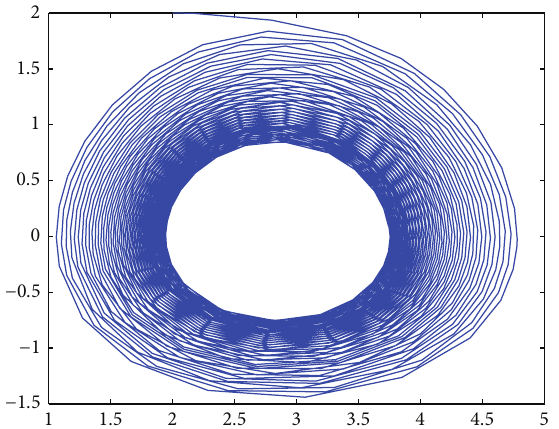
Figure 4: 𝜏 1 = 0 , 𝜏 2 = 0.7237 , (𝑝 ∗ ,0) , periodic solution bifurcates from (𝑝 ∗ , 0) .